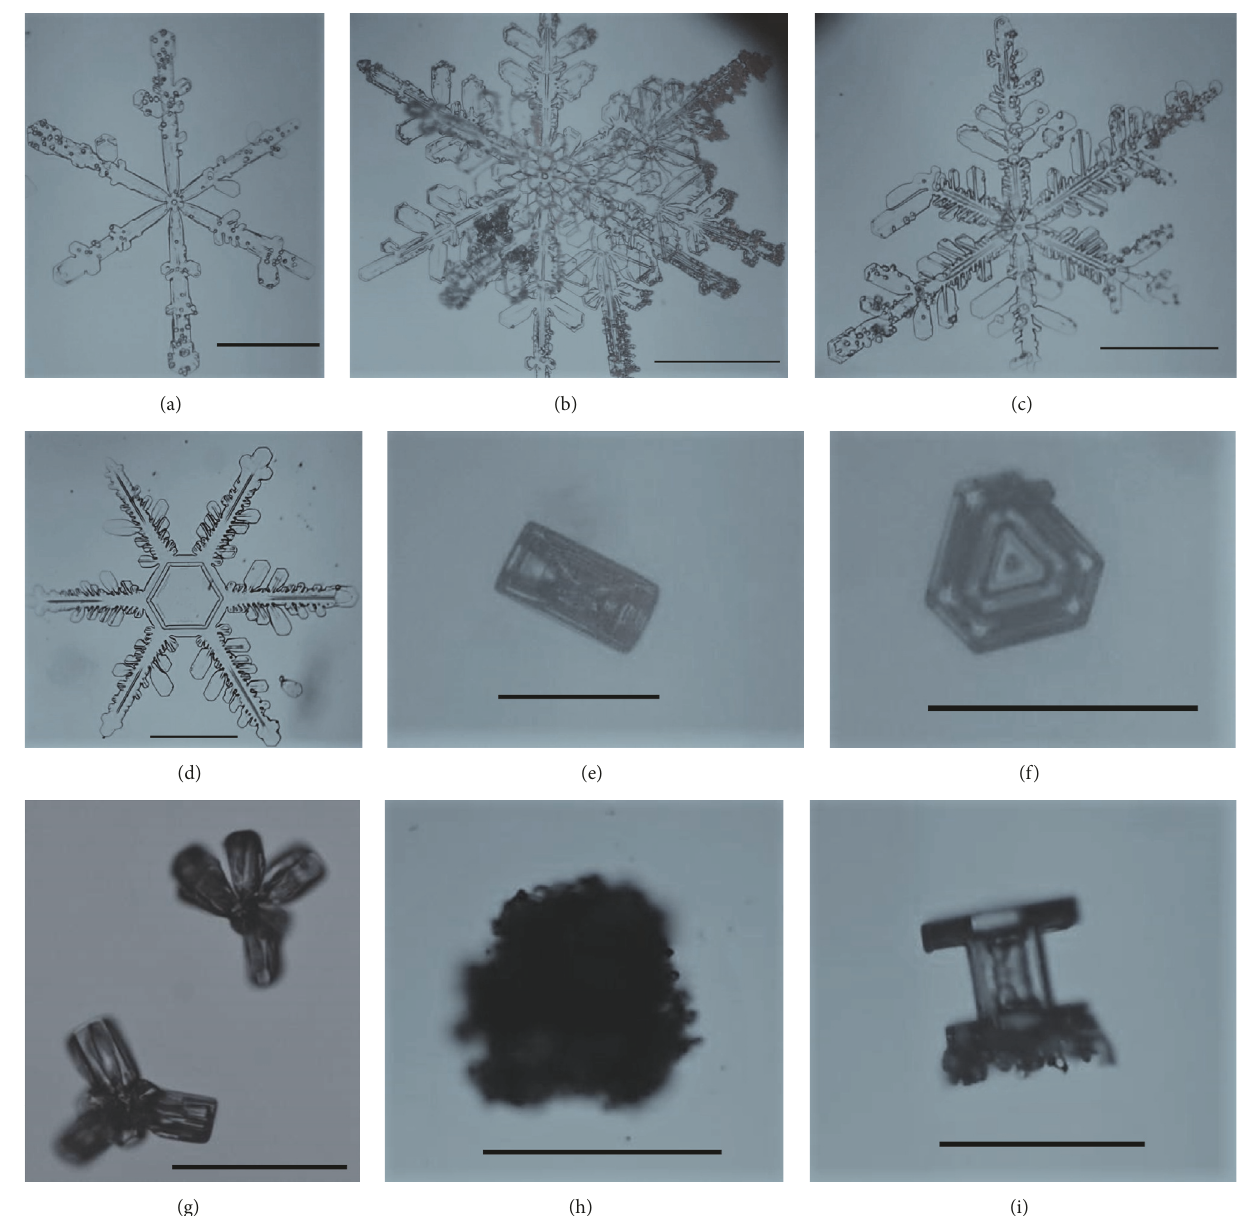
Figure 7: Some examples of solid precipitation particles collected at the Yan Jiaping in the Haituo Mountains. The black scale line represents